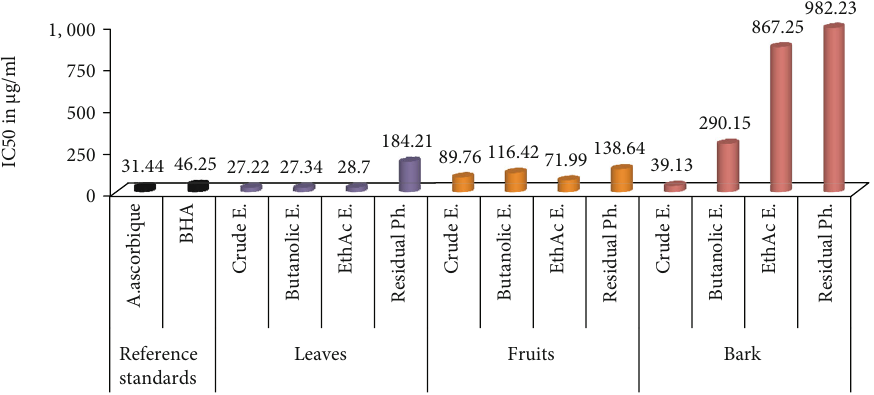
Figure 6: Inhibitory concentrations of 50% of free radicals DPPH (IC50 in μ